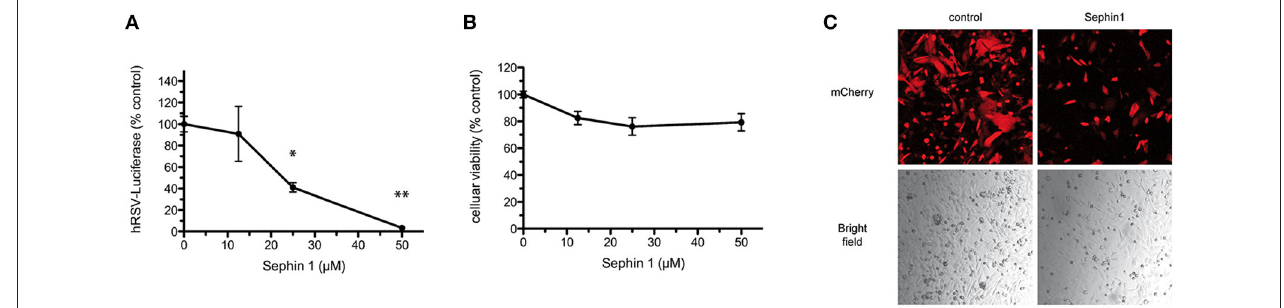
FIGURE 2 | Evaluation of the antiviral properties of Sephin1 against hRSV. (A) HEp-2 cells were infected with a recombinant strain of hRSV expressing luciferase and incubated with increasing doses of Sephin1 or DMSO alone. After 24h, luciferase expression was determined. (B) Viability of HEp-2 cells incubated with increasing doses of Sephin1 or DMSO alone was determined after 24h of incubation using the cellular viability assay Vita-Blue. (C) HEp-2 cells were infected with a recombinant strain of hRSV expressing mCherry and incubated with increasing doses of Sephin1 or DMSO alone. After 24h, cells were fixed and imaged using a confocal microscope. Data represent mean ± SEM from representative experiments, repeated at least three times. * p < 0.05, ** p < 0.01 by one-way analysis of variance, followed by Bonferroni comparison test comparing the Sephin1-treated group at the indicated concentration to the vehicle-treated control group.